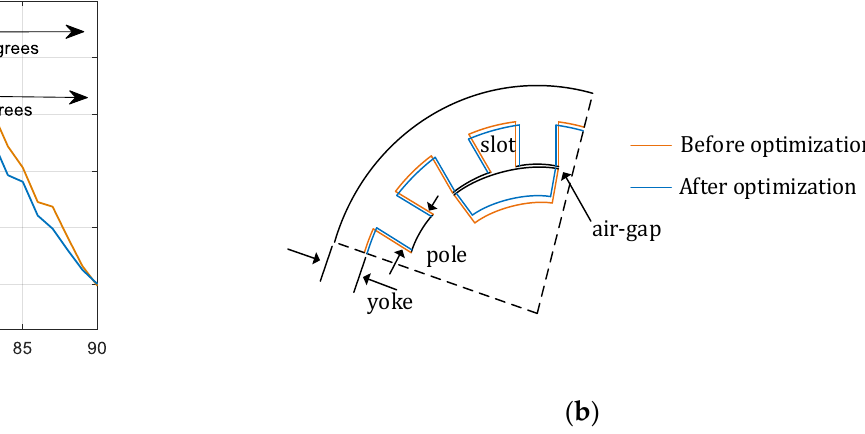
Figure 8. Optimization of the proposed SRM: ( a ) the optimization results of the torque; ( b ) the optimization result of the pole dimensions.